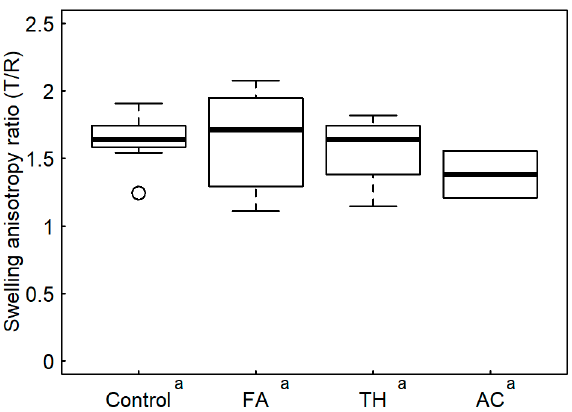
Figure 7. Swelling anisotropy ratios (T/R) calculated from the ratio of swelling coefficients. Super- scripted letters on the x -axis indicate significant differences according to Tukey’s HSD test.